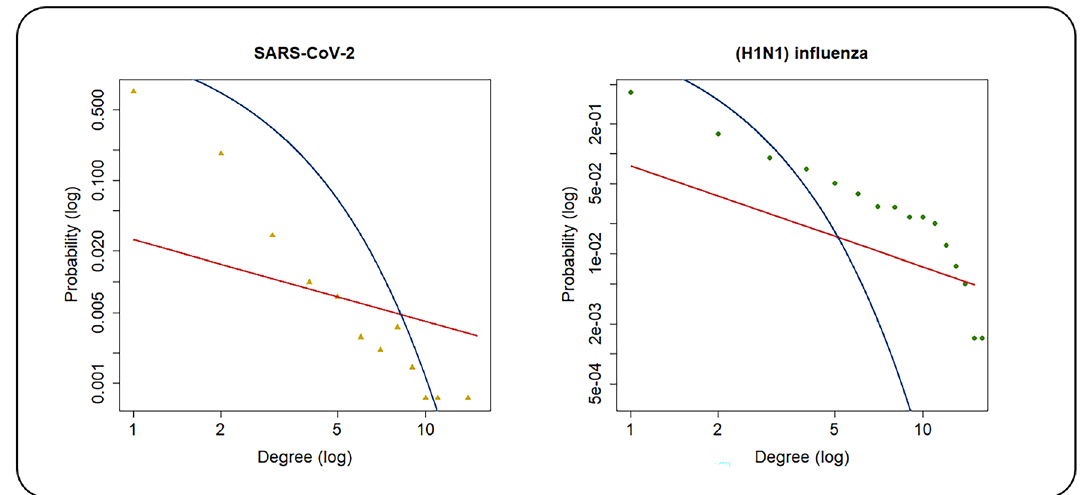
Figure 1. Fitting both SARS-CoV-2 and (H1N1) influenza PPINs on power-law distribution.